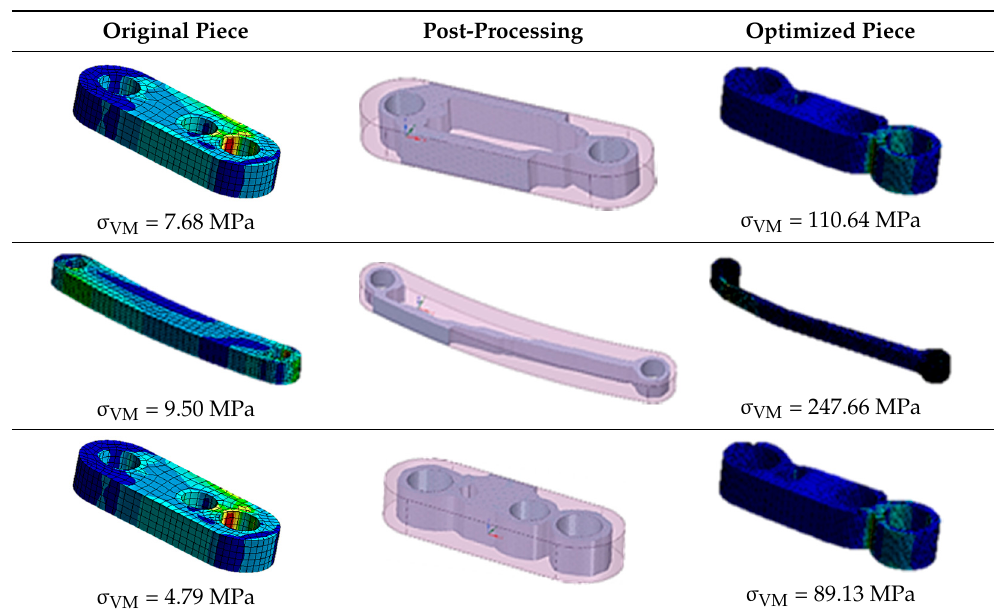
Table 6. Results of the six-bar mechanism. Original Piece Post-Processing